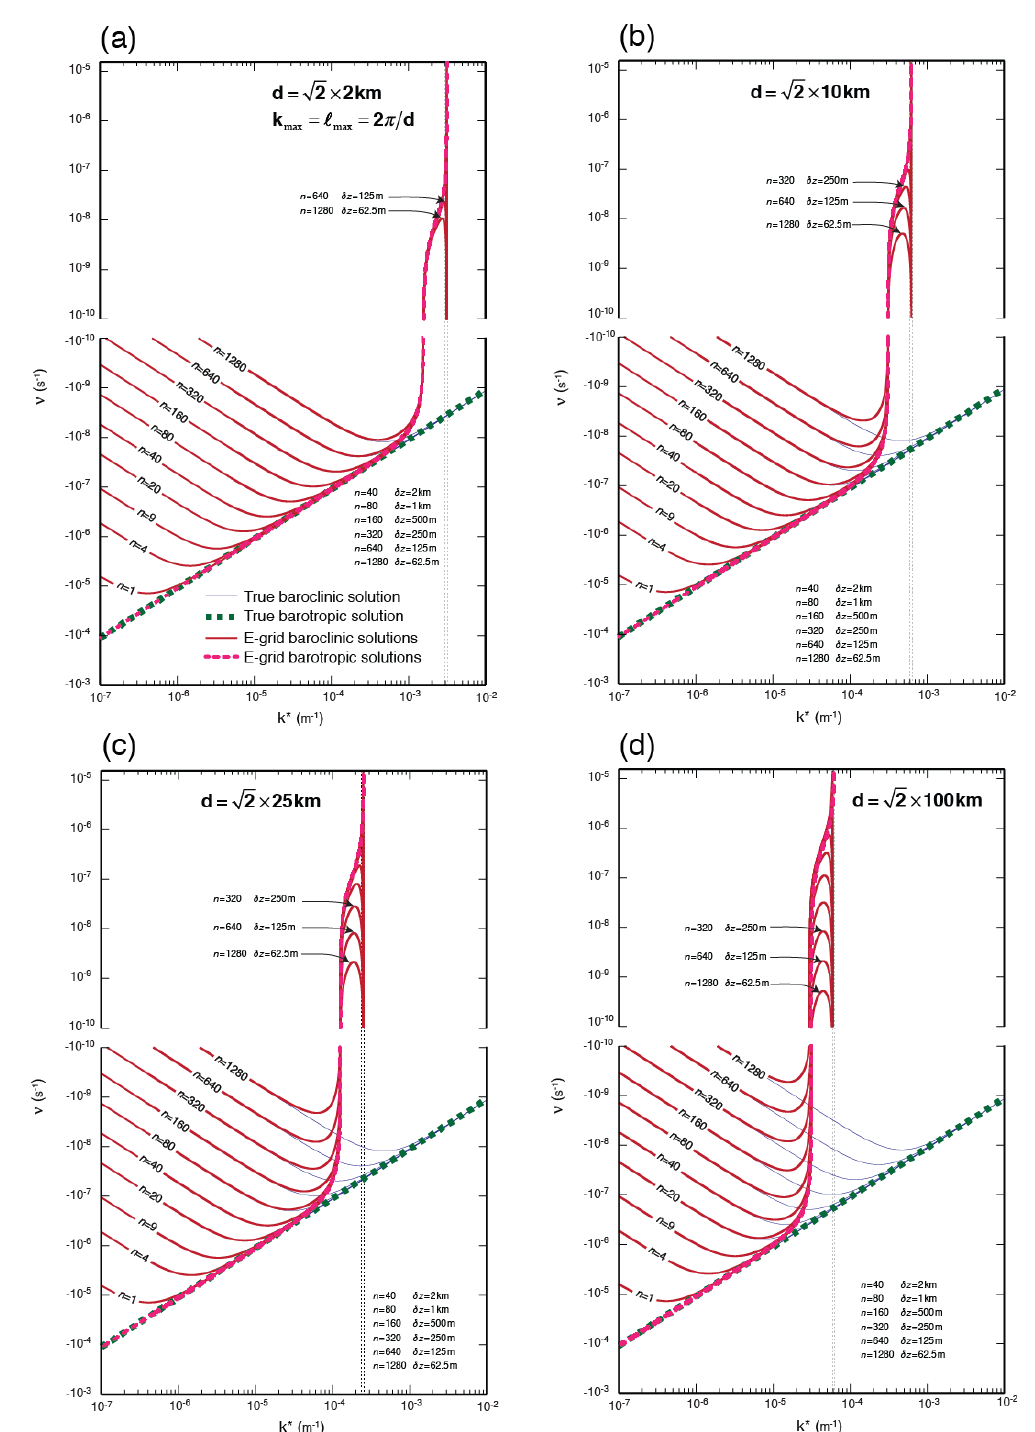
Figure 5. Same as Fig. 1 but on the E